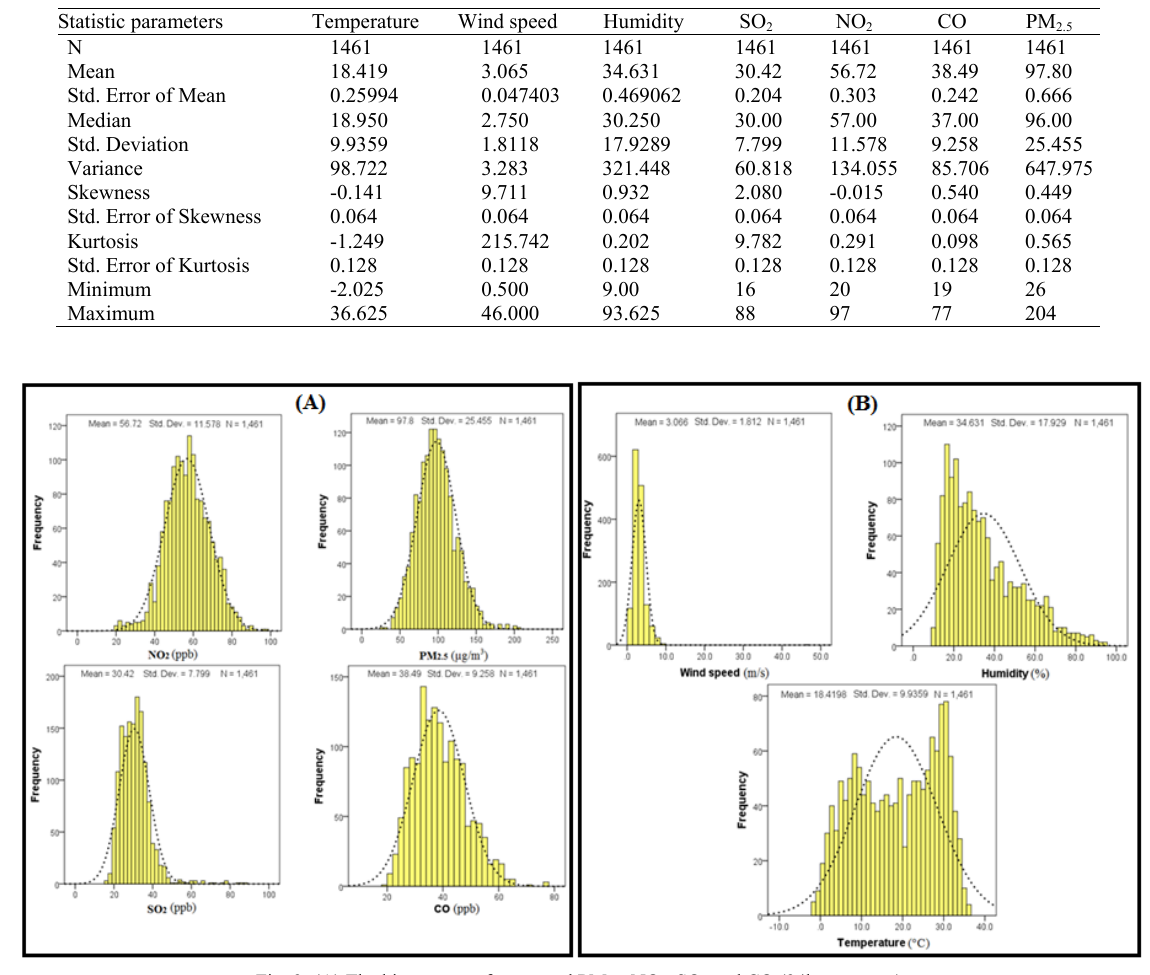
Fig. 2: (A) The histograms of measured PM 2.5 , NO 2 , SO 2 and CO (24h. averages). (B) The histograms of measured humidity, wind speed, and temperature (24h. averages)